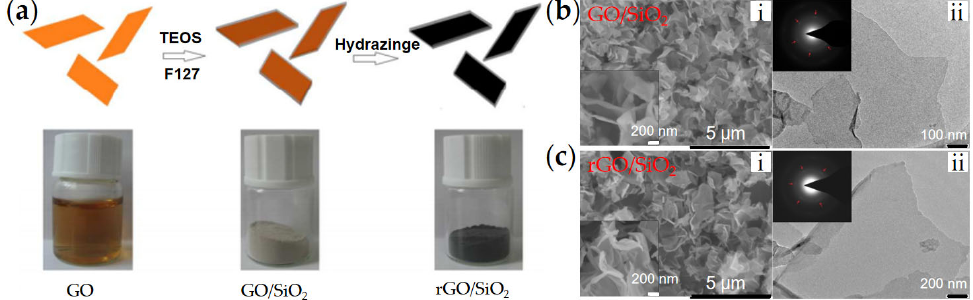
Figure 7. ( a ) Schematic preparation of rGO/SiO 2 nanoplates by TEOS hydrolysis on the surface of GO and hydrazine treatment; ( b ) SEM image (i), TEM image (ii) and SAED (inset) of GO/SiO 2 ; ( c ) SEM image (i), TEM image (ii) and SAED (inset) image of rGO/SiO 2 [68].